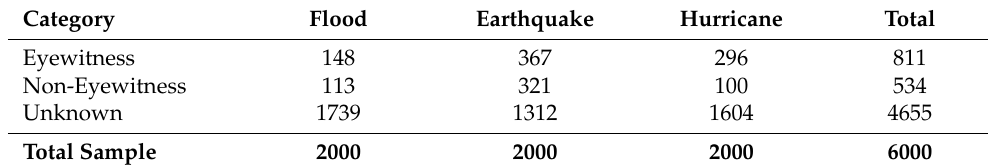
Table 3. Statistics of Training